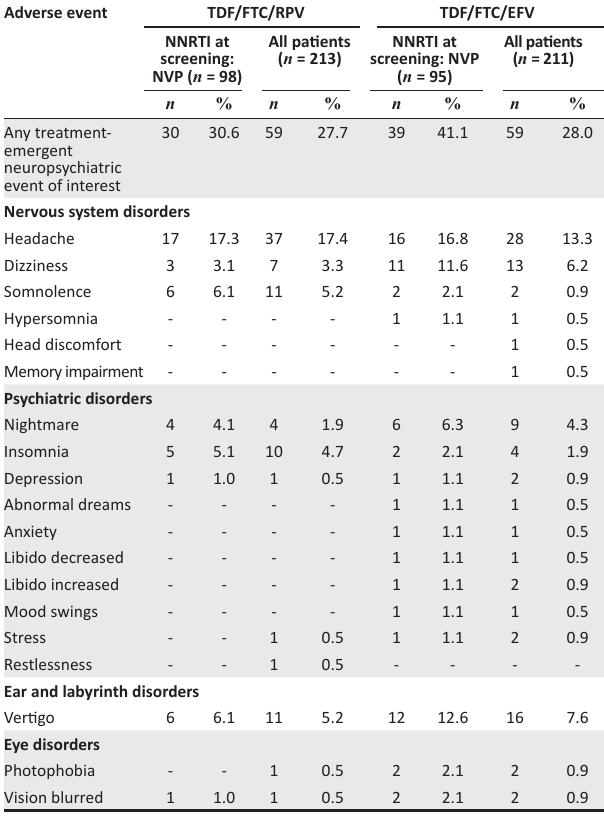
TABLE 4: Treatment-emergent neuropsychiatric events of interest in the subgroup of patients switching from NVP and the full ITT